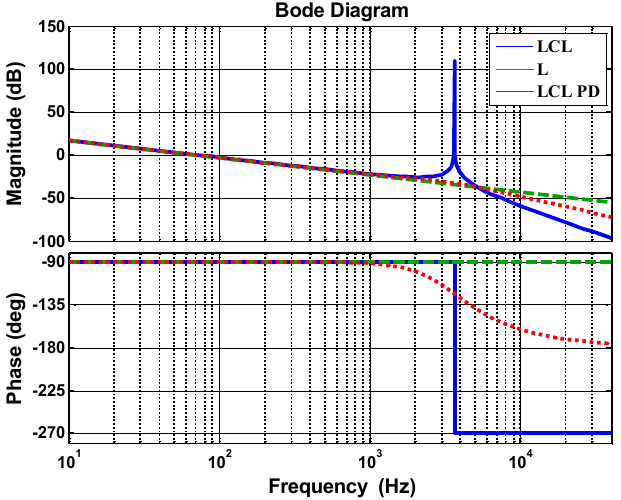
Figure 7. LCL, and L filters Bode